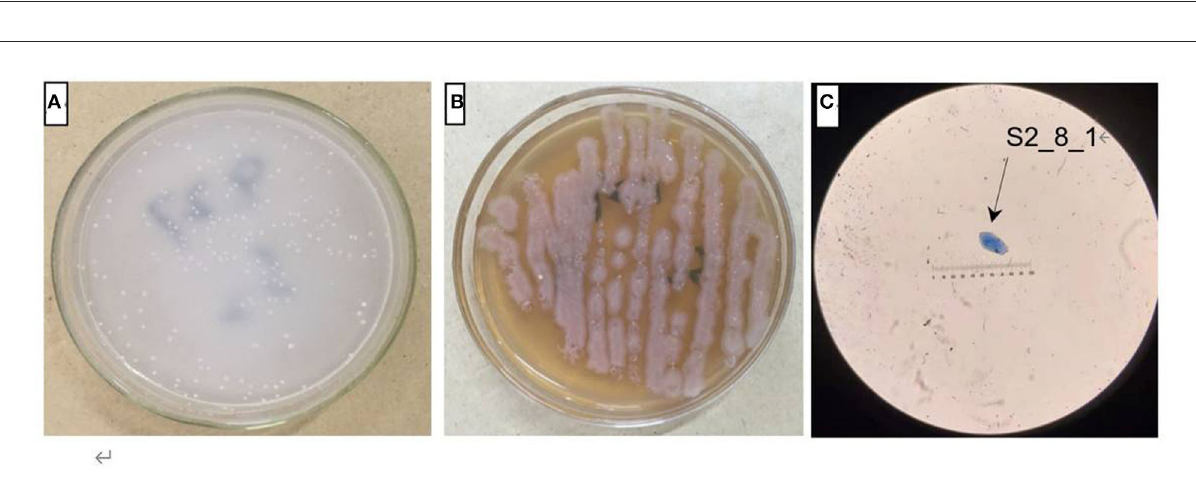
FIGURE3 Cell and colonial morphology of strain S2_8_1. The S2_8_1 was the strain that has been isolated and screened in the present study. (A,B) showed the morphology characteristics of cell and colony of strain S2_8_1 in separation and LB mediums, respectively. (C) showed the size and sharp of strain S2_8_1,